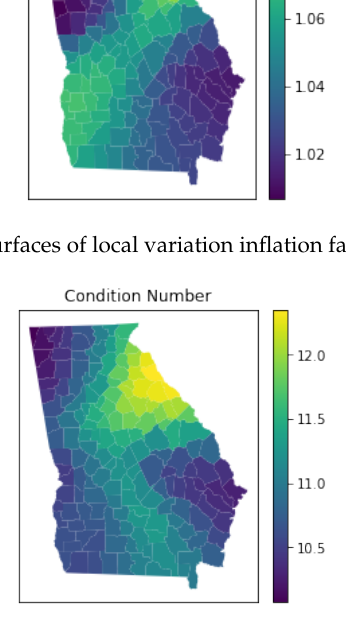
Figure 10. Surface of local condition number.